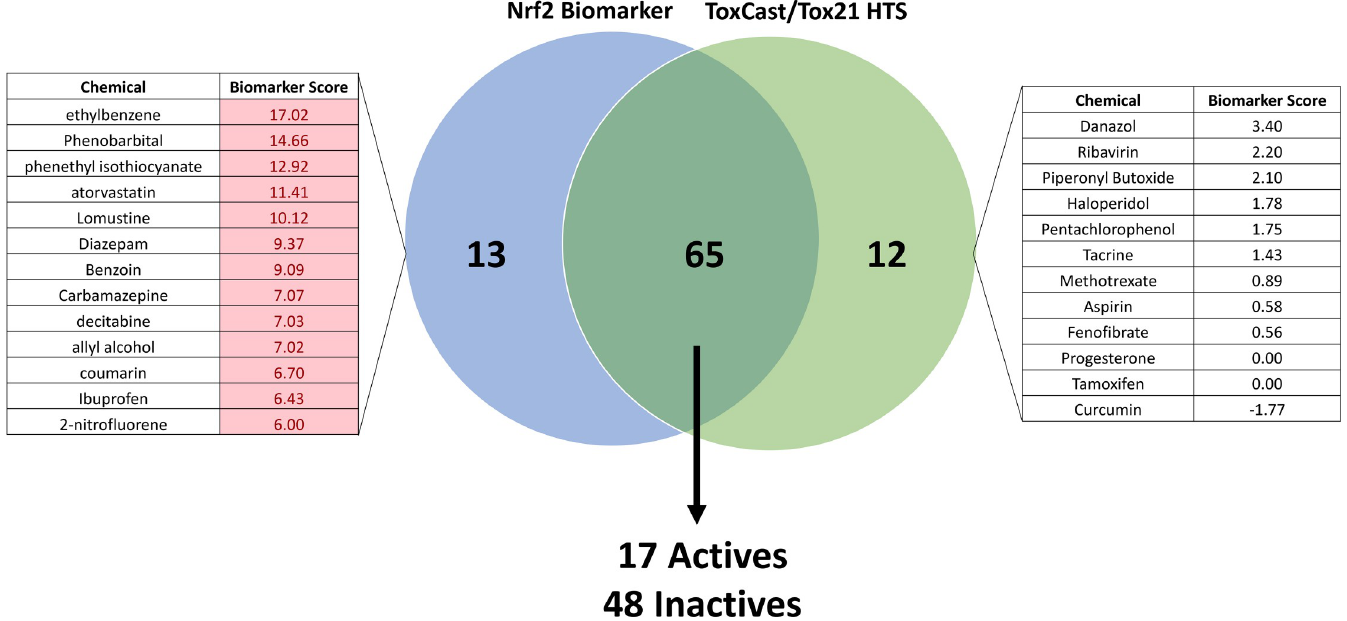
Fig 6. Biomarker prediction agreement with HTS NRF2 assay results. Maximum biomarker scores for each chemical were extracted from the database of HepG2 and hepatocyte experiments, and activity calls based on these scores were compared with activity determinations from ToxCast and Tox21 NRF2 HTS assays. Chemicals examined at a concentration above the HTS-determined cytotoxicity threshold for that chemical were excluded from the analysis. Lists represent those chemicals classified as NRF2-active by the biomarker only (left) or by HTS only (right). Biomarker score values shaded in red indicate results that are � -Log(p-value) = 4 for activation of NRF2